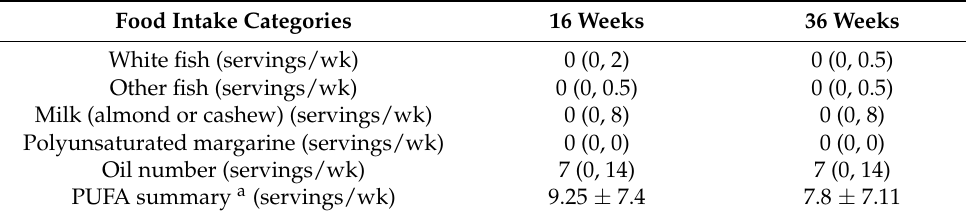
Table 2. Self-reported frequency of food consumption per week at 16 and 36 weeks